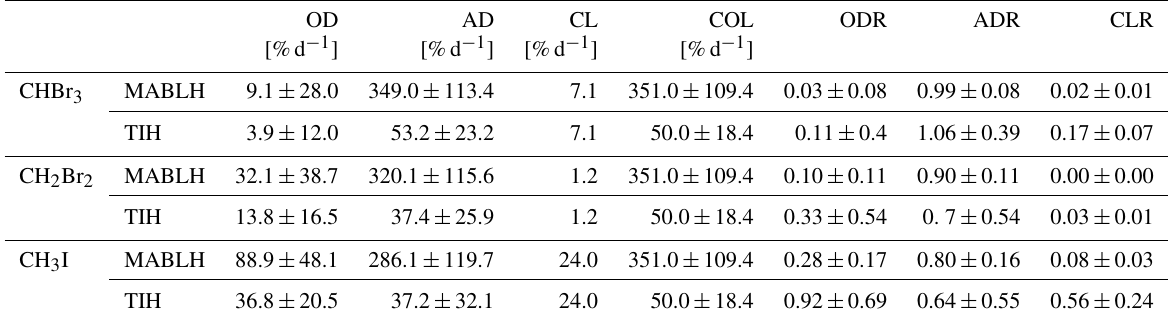
Table 3. VSLS source–loss calculations: mean ± 1 σ of oceanic delivery (OD), advective delivery (AD), chemical loss (CL), convective loss (COL), oceanic delivery ratio (ODR), advective delivery ratio (ADR) and chemical loss ratio (CLR) of bromoform (CHBr 3 ) , dibro- momethane (CH 2 Br 2 ) and methyl iodide (CH 3 I). Parameters have been computed for a box with the vertical extension of the in situ MABL height (MABLH) and a mean trade inversion height (TIH) of 1.1km. OD AD CL COL